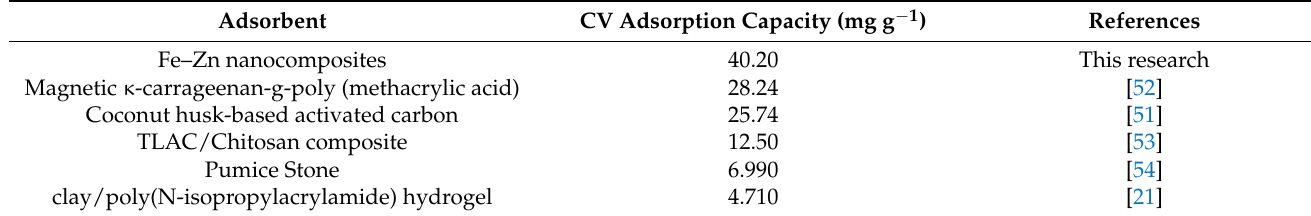
Table 7. Comparison of the adsorption efficacy of the IZNC with earlier